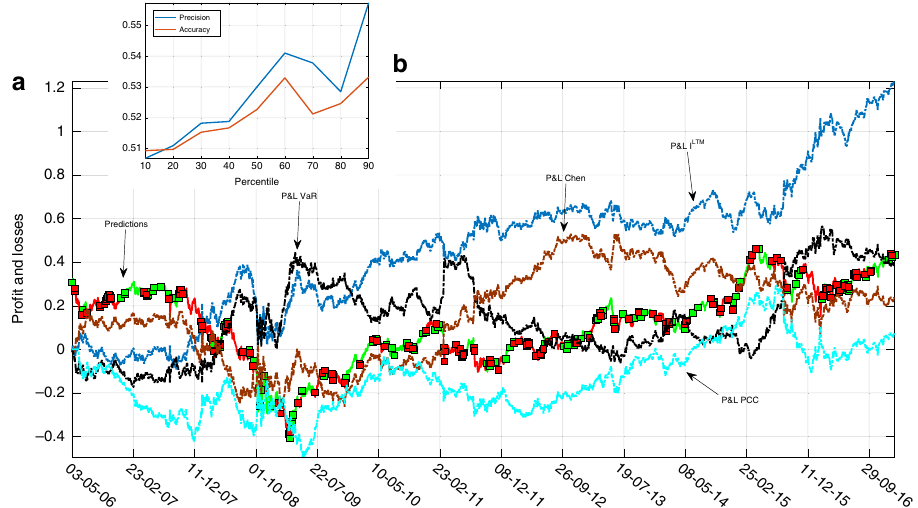
Fig. 3 The buy/sell signals provided by the dynamics of I LTM t and of its members ’ returns together with the obtained Pro fi ts and Losses (P&L). The fi gure reports, in a , the forecast dynamics of the benchmark index (green-red colors stand for buy and sell signals, respectively) together with the P&L of the investment strategy based on I LTM t (blue line). The P&L of an investment strategy based on the value at risk (VaR), that is, the maximum potential loss computed on a daily time horizon with an interval of con fi dence of 0.975 is also reported (black line) as a comparative measure. The true positives, false positives, false negatives, and true negatives obtained by investing following I LTM t are 53%, 47%, 49%, and 51%, respectively, while for the strategy based on the VaR, we obtain 49%, 51%, 52%, and 48%. Finally, the brown line refers to the P&L evolution obtained by considering an investment strategy based on the indicator proposed by ref. 58 , while the cyan line shows the P&L obtained when considering only the average correlation among stocks' returns. In b , we report the accuracy and precision measures of the proposed investment strategy conditionally on the forecast of the market index returns larger than a certain percentile of their distribution in absolute